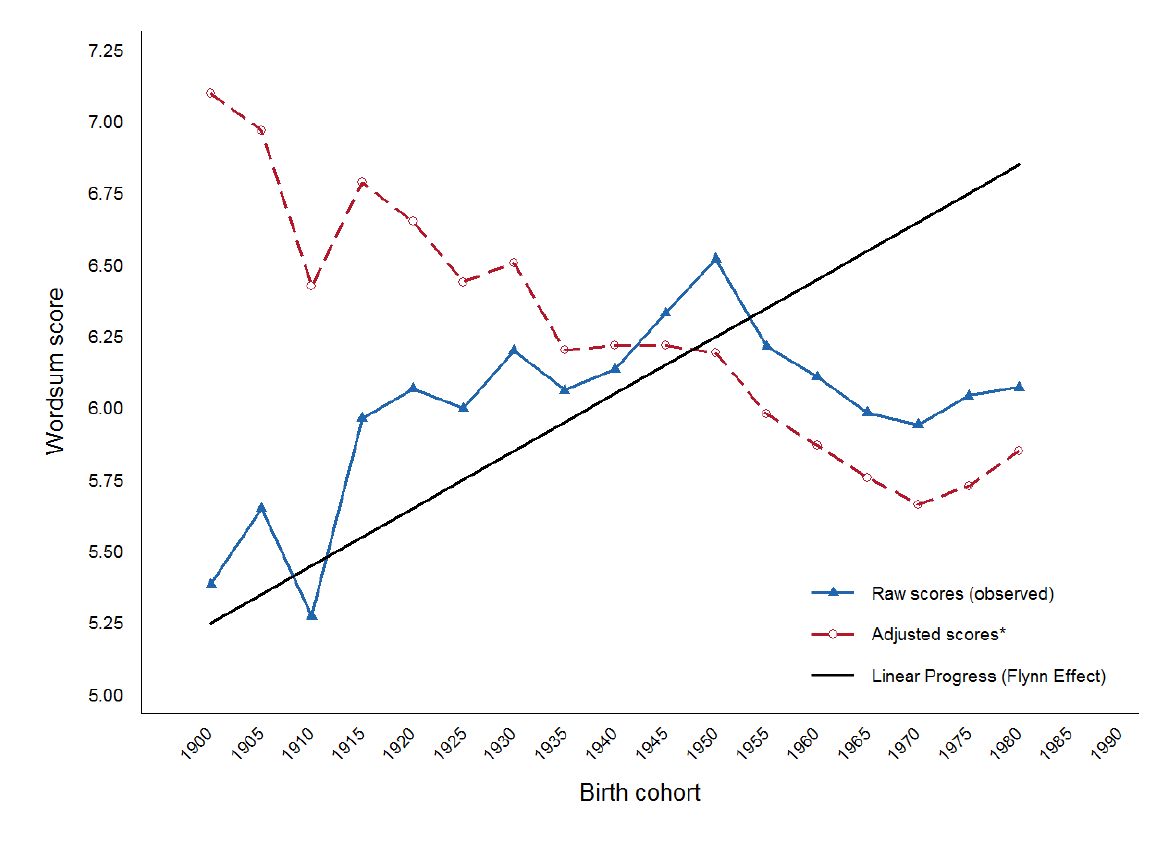
Figure 1: Raw and adjusted WORDSUM test scores, by birth cohort: General Social Survey, 1974–2012. Note: Estimates sample weighted and adjusted for respondent age and education. First and last birth cohort categories were collapsed as follows: 1900 = 1885–1900; 1980 =